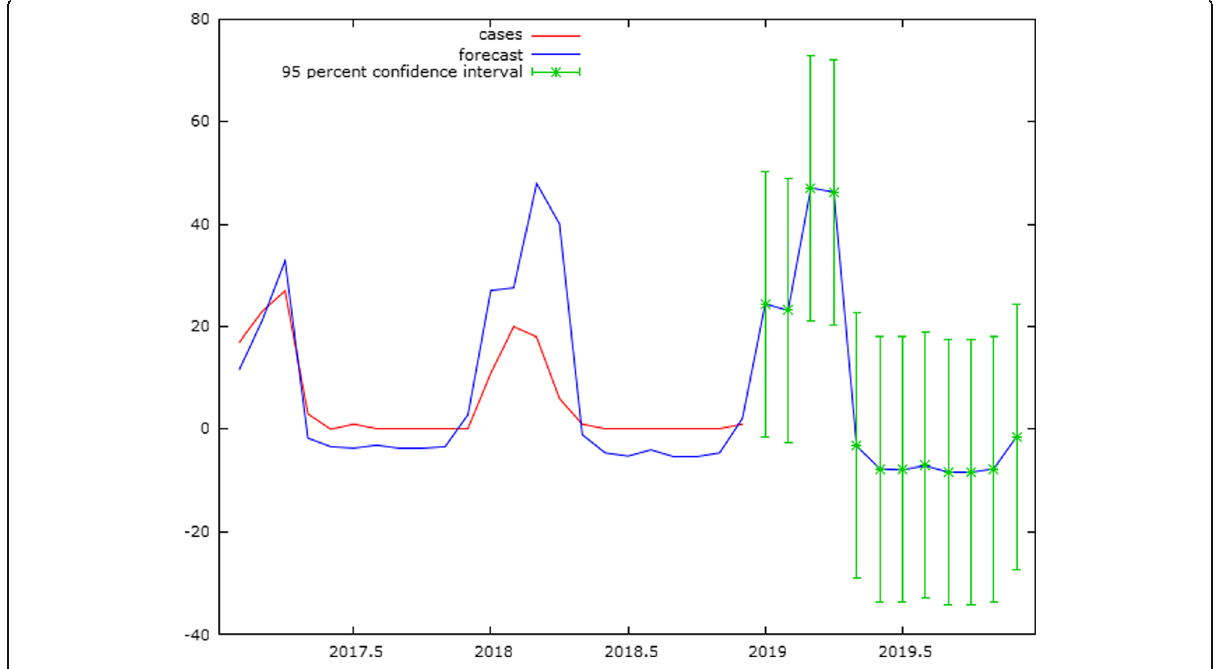
Fig. 7 Actual and fitted cases of Kyasanur Forest Disease in Goa, India, showing a seasonal trend using SARIMA model